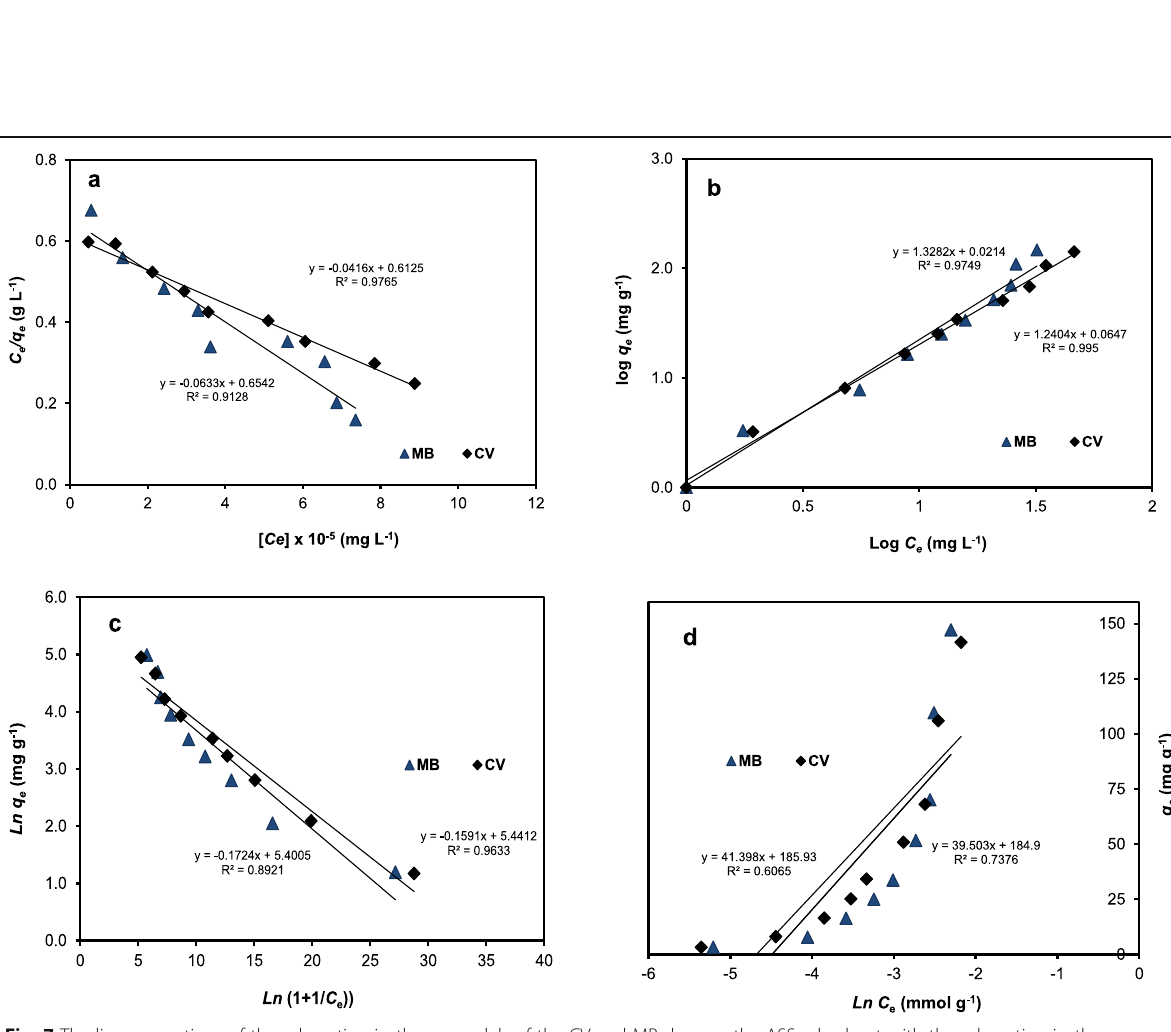
Fig. 7 The linear equations of the adsorption isotherm models of the CV and MB dyes on the ASS adsorbent with the adsorption isotherm model of ( a ) Langmuir, ( b ) Freundlich, ( c ) Dubinin-Raduskevich, and ( d )